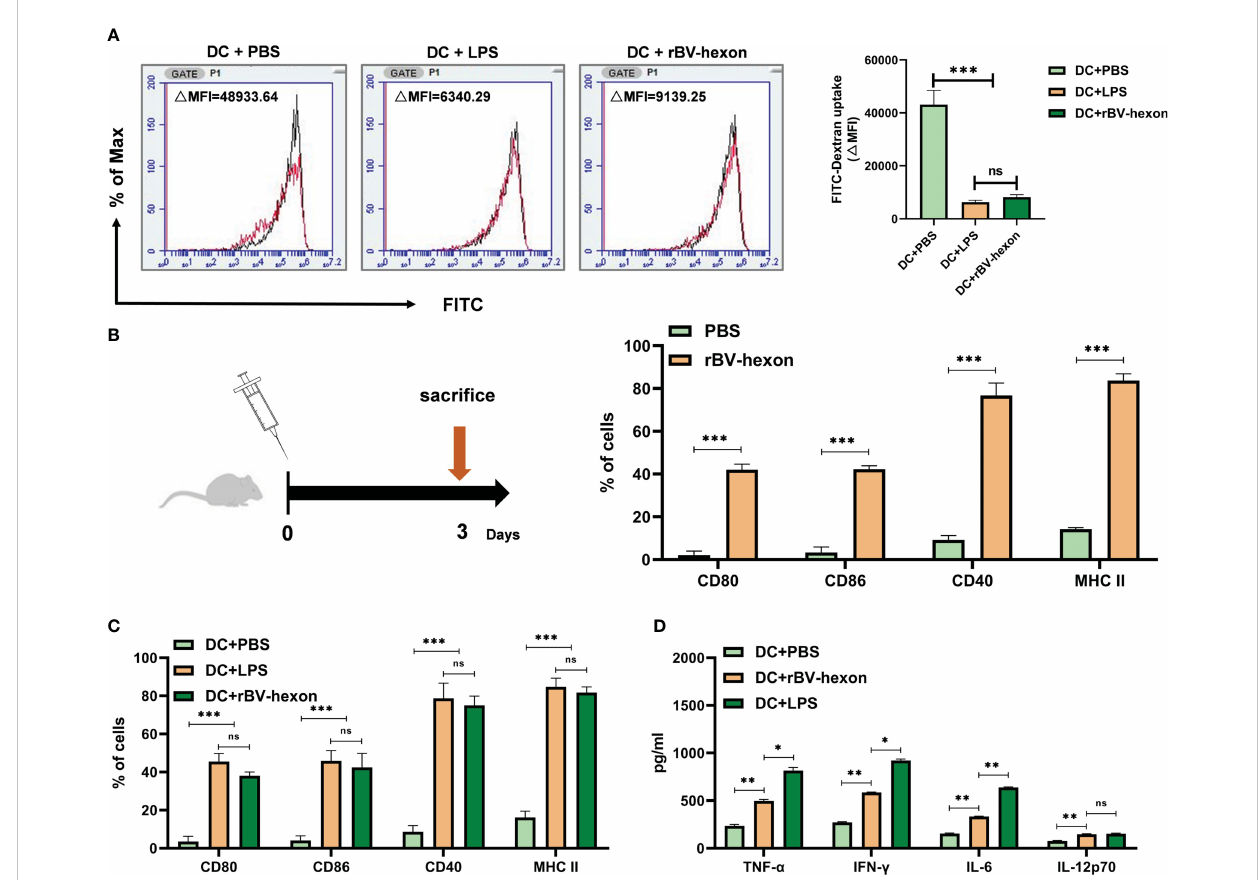
FIGURE 2 DCs can be induced to absorb antigen and mature by recombinant subunit vaccine rBV-hexon. (A) Fluorescence intensity of DCs incubated with PBS, LPS and rBV-hexon at 37°C was analyzed by fl ow cytometry. The samples at 4°C served as the negative control (Red). (B) Naïve mice (C57BL/6, n=6) were immunized with rBV-hexon and PBS was used as a negative control. After 3 days of immunization, spleen lymphocytes were isolated, and the percentages of CD80, CD86, CD40 and MHC-II expression in Dendritic cells were analyzed by fl ow cytometry. (C) BMDCs were incubated with PBS, LPS and rBV-hexon and the expression of cell surface markers was detected by fl ow cytometry. (D) Cytokine secretion was detected by ELISA after incubating BMDCs with PBS, lipopolysaccharide and rBV-hexon. The experiments were repeated with three independent experiments.